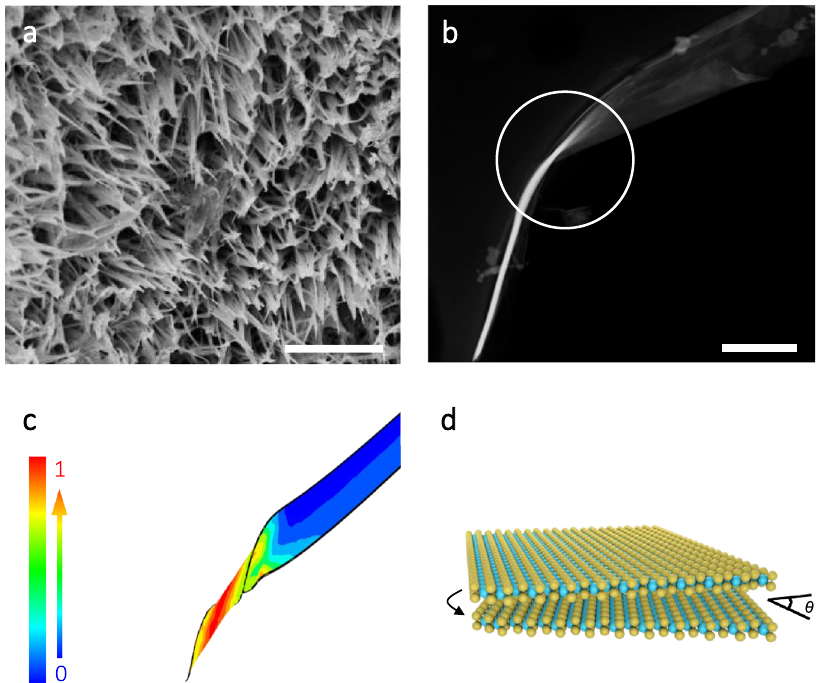
Fig. 1 Morphological and structural characterizations. a FESEM image of the as-prepared WS 2 nanoarrays. Scale bar, 2 μ m. b STEM image of single screwed WS 2 nanobelt. Scale bar, 300 nm. c Finite-element calculations of strain in a nanocone. The color bar shows the relative scale of the strain distribution. d Schematic diagram of moire ́ superlattices formed by S – W – S layer slipping. Yellow and cyan balls represent S and W atoms,